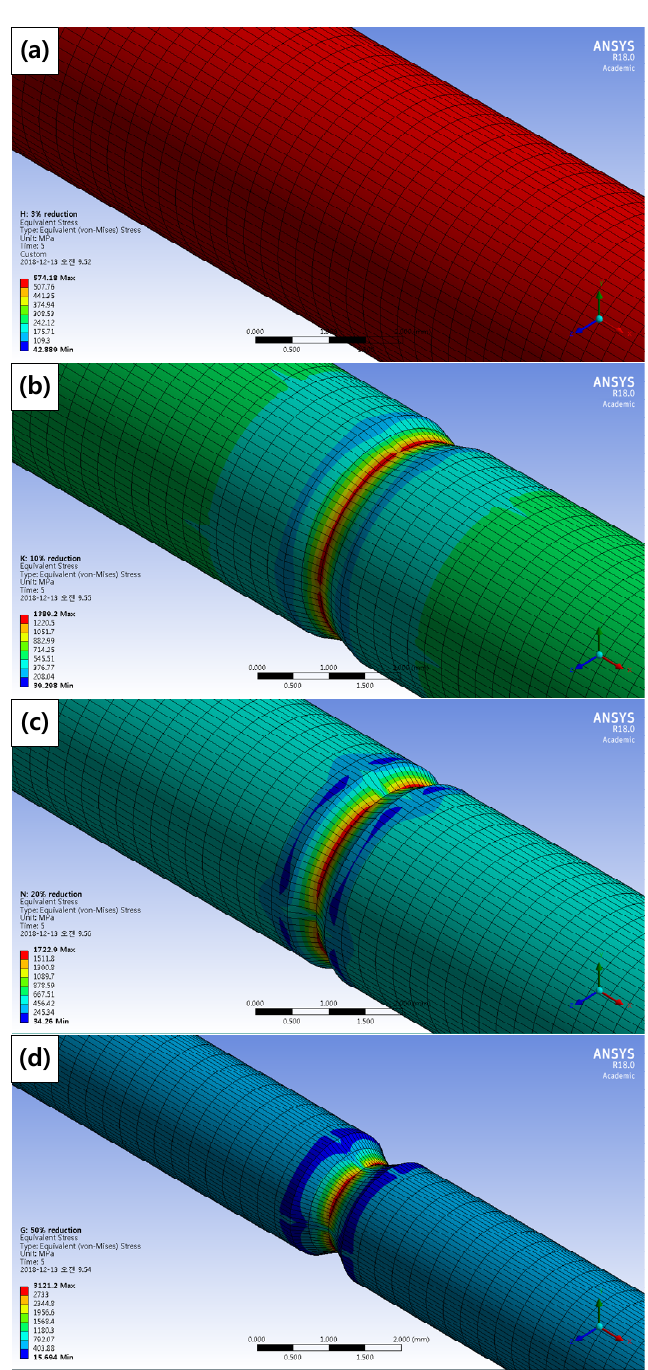
Figure 14. Maximum stress distribution of the corroded tensile specimens according to the diameter reduction by computer simulation: ( a ) 3%, ( b ) 10%, ( c ) 20%, and ( d ) 50% diameter reduction specimens.